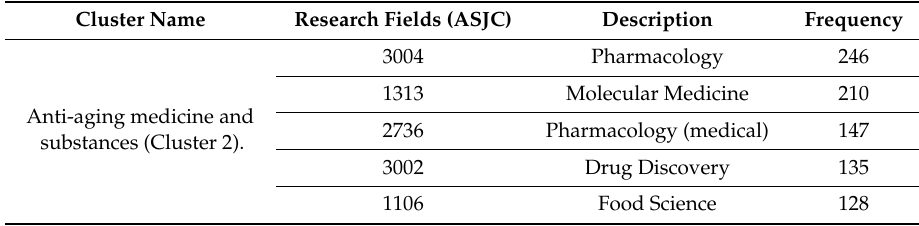
Table 3. Major research fields in Anti-aging medicine and substances (Cluster